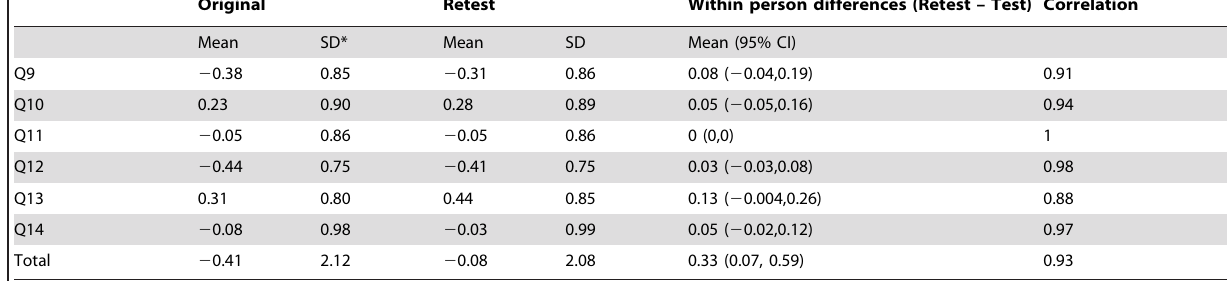
Table 1. Test-Retest Results.